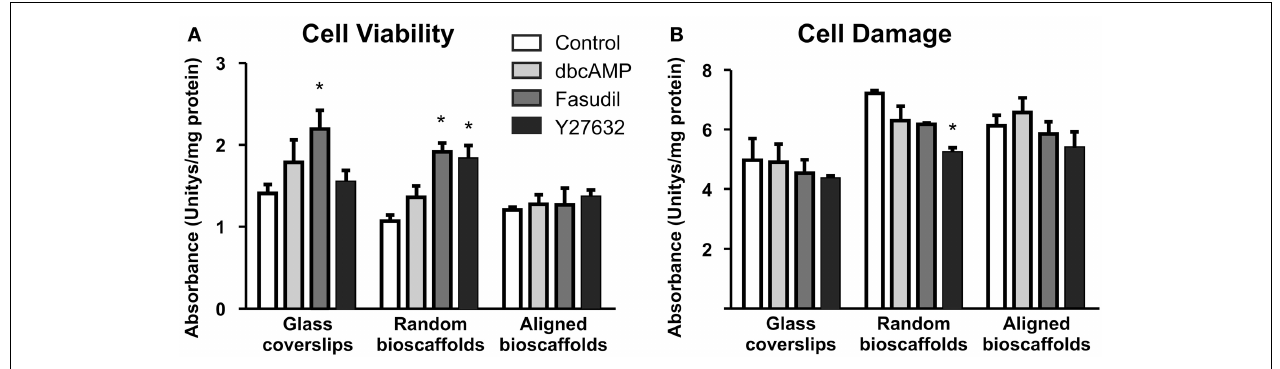
FIGURE 4 | Effect of drug treatments on cell viability and cell damage. Astrocytes were treated for 72h with vehicle (Control), dbcAMP (1mM), Fasudil (100 μ M) or Y27632 (30 μ M) on glass coverslips, random or aligned bioscaffolds. Cell viability was determined by the 3-(4,5-dimethylthia zol-2-yl)-2,5-diphenyltetrazolium bromide assay (A) , while cell damage was